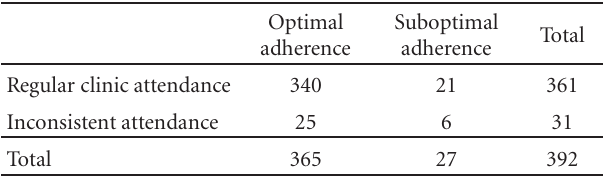
Table 3: Comparison of clinic attendance with adherence for the ART treatment cohort.